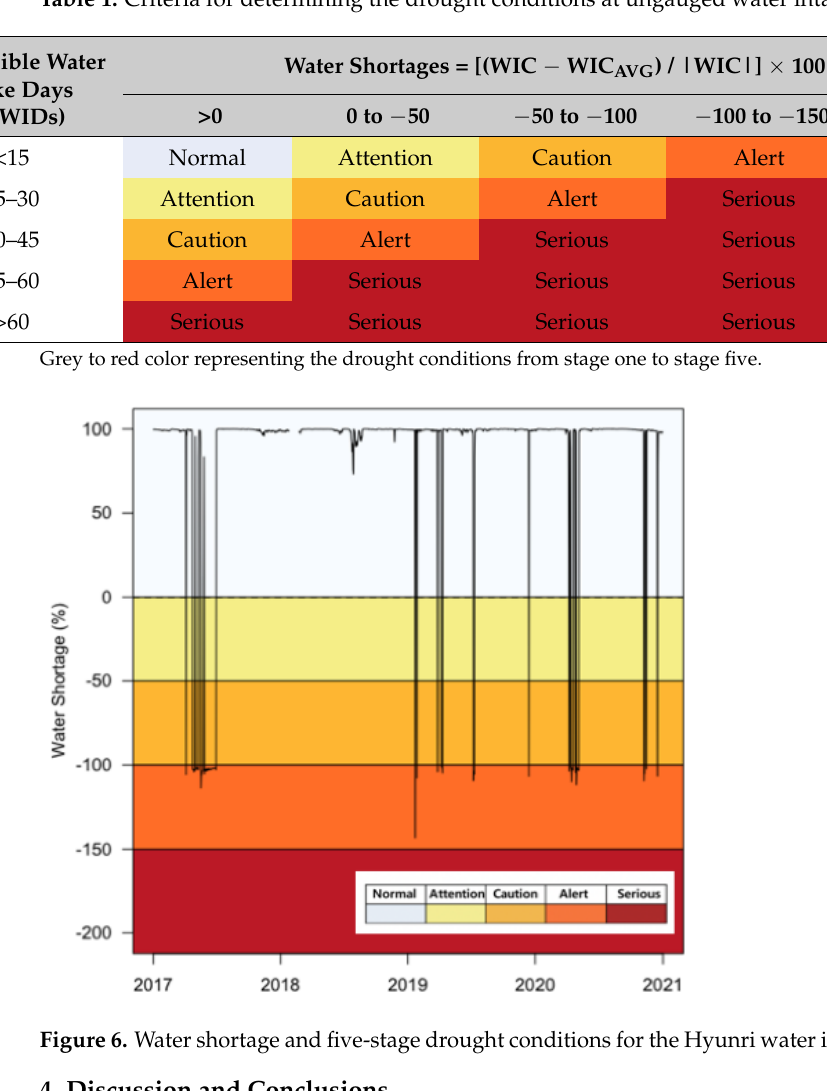
Table 1. Criteria for determining the drought conditions at ungauged water intake plants (WIPs).